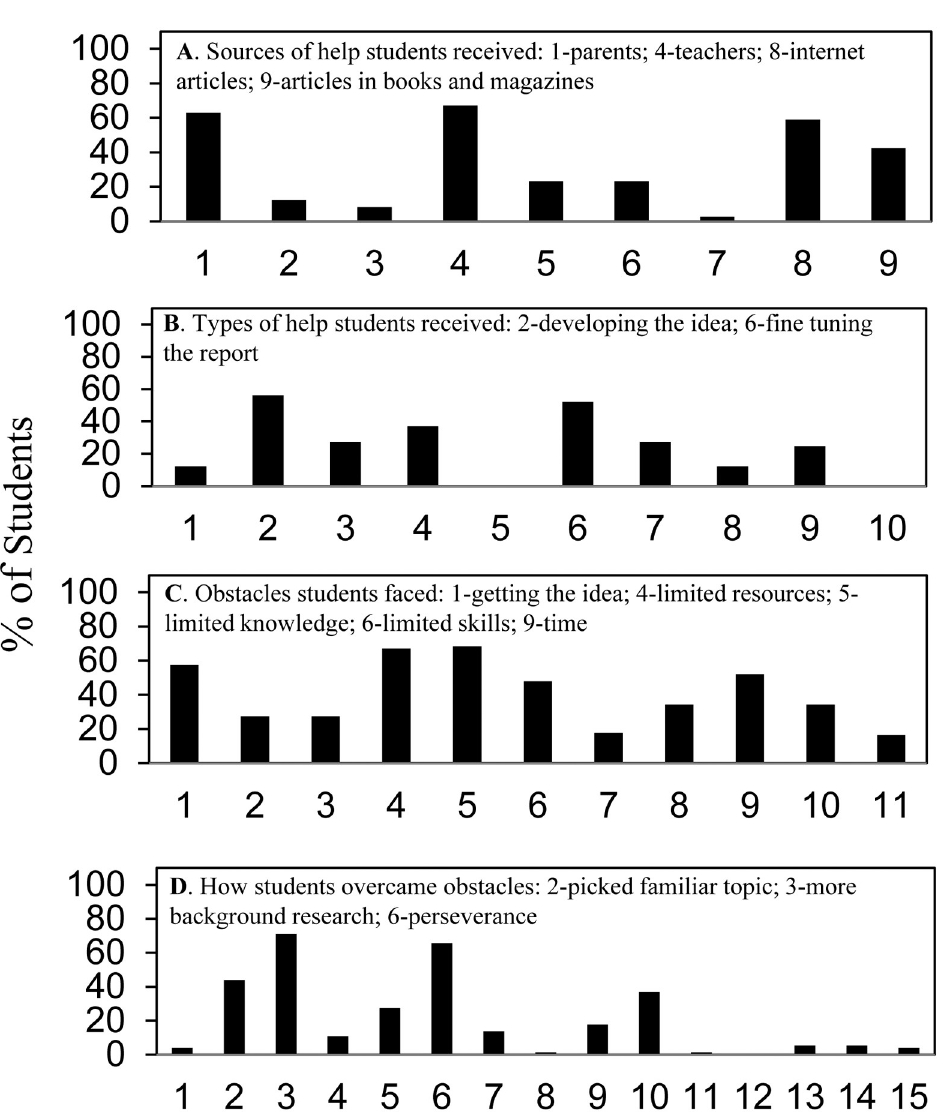
Fig 4. Summary of student science fair experiences regarding help and